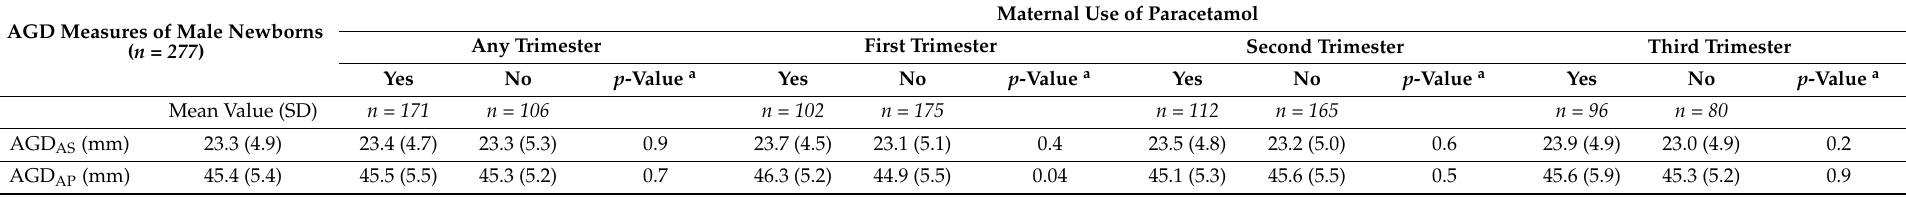
Table 2. Anogenital distance measurements of males (N = 277) at birth cohort NELA according to the maternal use of paracetamol during pregnancy. p -value ≤ 0.05 is considered statistically significant.